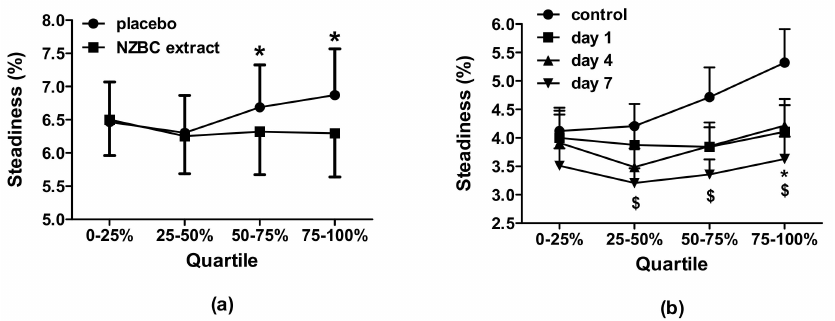
Figure 1. Isometric force steadiness in the quartile sections during a 120 s submaximal (30%MVC) isometric contraction of the quadriceps muscles: ( a ) Effects of 7-day intake for placebo and NZBC extract, * = difference between placebo and 7-day intake of NZBC extract in the 3rd and 4th quartiles; ( b ) Effects of 1-, 4- and 7-day intake of NZBC extract and control (no intake), * = difference between 1 day and control, $ = difference between 7 days and control. NZBC, New Zealand